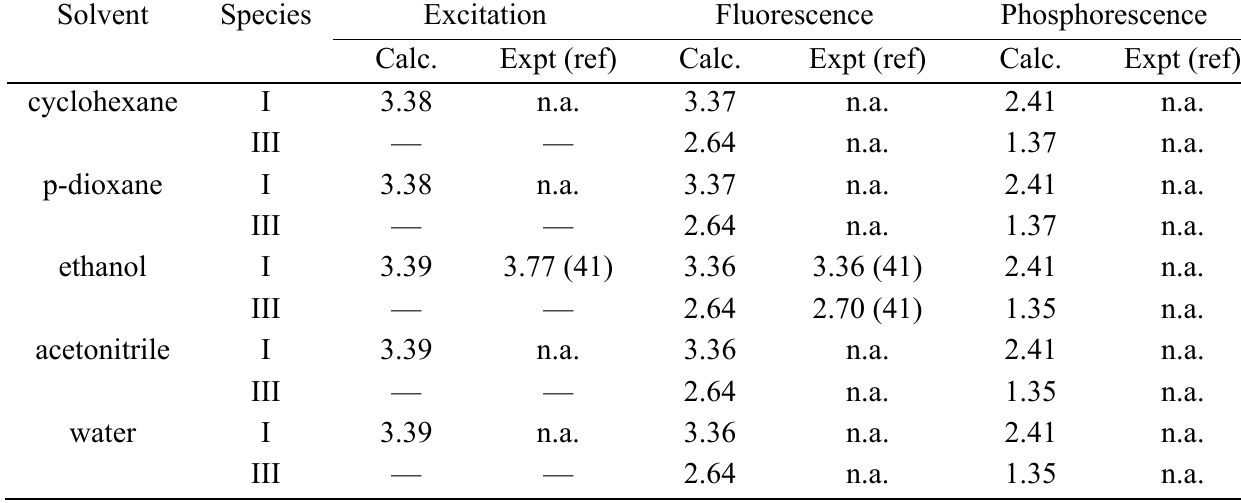
Table 11. Assignment of excitation, fluorescence and phosphorescence spectra of HBT in different solvents in terms of calculated energies (eV). Numbers within parentheses refer to the references corresponding to the experimental data. (n.a. indicates non-availability of data).